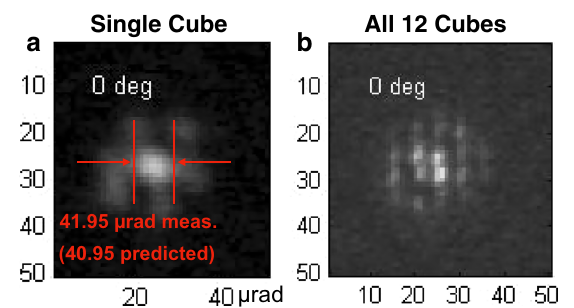
Fig. 2 Far‑field pattern at normal incidence. Measurements from the optical test for a single cube ( a ) and for the whole array ( b ). Axes are in